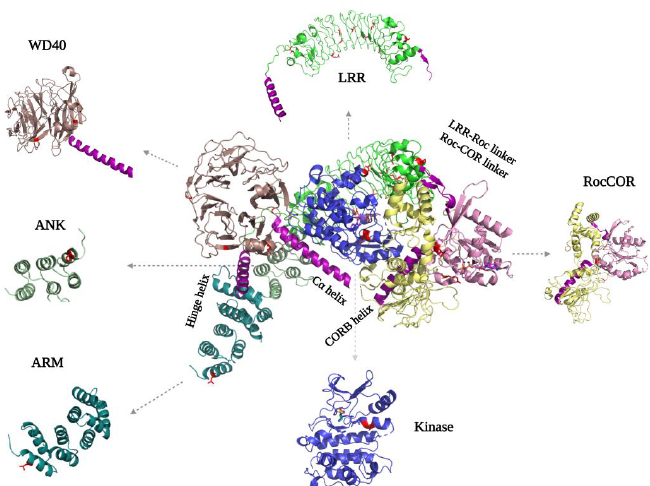
Figure 4. flLRRK2 (PDB ID: 7LHW) with the separated domain’s structure on the sides. The helixes that are important for interdomain mediation are highlighted in purple. The PD mutations are indicated in both the full-length structure and separate domains in red, where they are located either in intradomain or interdomain interfaces. For the ANK domain, it was initially predicted that it consists of seven repeats from aa679-902, while a later study proposed it consists of five repeats from aa690 to aa860 [51,55]. However, both the flLRRK2 and AlphaFold2 structures show that the ANK do- main only comprises three typical antiparallel helix repeats (aa705-795) that are connected by a hairpin (Figure 4). The LRRK2 ANK domain forms a typical L-shaped structure with the extended hairpin exposed to the outside to mediate PPIs [56–58]. The structures also revealed that the predicted C-terminal segment of the ANK domain (aa795-860) is actually part of the LRR domain, where it functions as a hinge helix that connects the LRR domain with the ANK, ARM, and WD40 domains [24]. The LRR domain of flLRRK2 is folded into a 14 + 1 repeat horse-shaped structure [24]. The beta-strand is located at the concave surface, and it is connected with the convex side α-helix by a loop [24]. After the last strand-helix repeat at the C-terminus of the LRR do- main, there is a short linker that crosses the Roc–CORA linker and forms a connection with the Roc domain (Figure 4). In the Ct Roco protein, this linker between the LRR and Roc domain is around 40 residues in length and includes a PLxxPPPE motif that is con- served in prokaryotic Roco proteins [29]. This linker in Ct Roco was shown to be important for the stability of the Roc–COR construct protein, and the crystal structure showed direct interaction of the linker with the Roc domain switch II motif [29,32]. However, in both the flLRRK2 and AlphaFold2 structures, the linker and LRR domain are far away from the Roc catalytic core. The crystal structure of the dimeric WD40 domain published by Zhang et al. in 2019 revealed a typical seven blade ring-like structure, each consisting of four anti-parallel β- strands [17] (Figure 4). The WD40–WD40 dimeric interface is formed by the circumference of blades V, IV, and VI, rather than by the popular blade top surfaces. Consistently, this same WD40 dimer interface is present in the microtubule-bound LRRK2 in situ structure and the trimeric LRRK2 RCKW EM structure [23,26]. Interestingly, the extended LRRK2 RCKW , flLRRK2, and AlphaFold2 structures also show that the C-terminal helix of the WD40